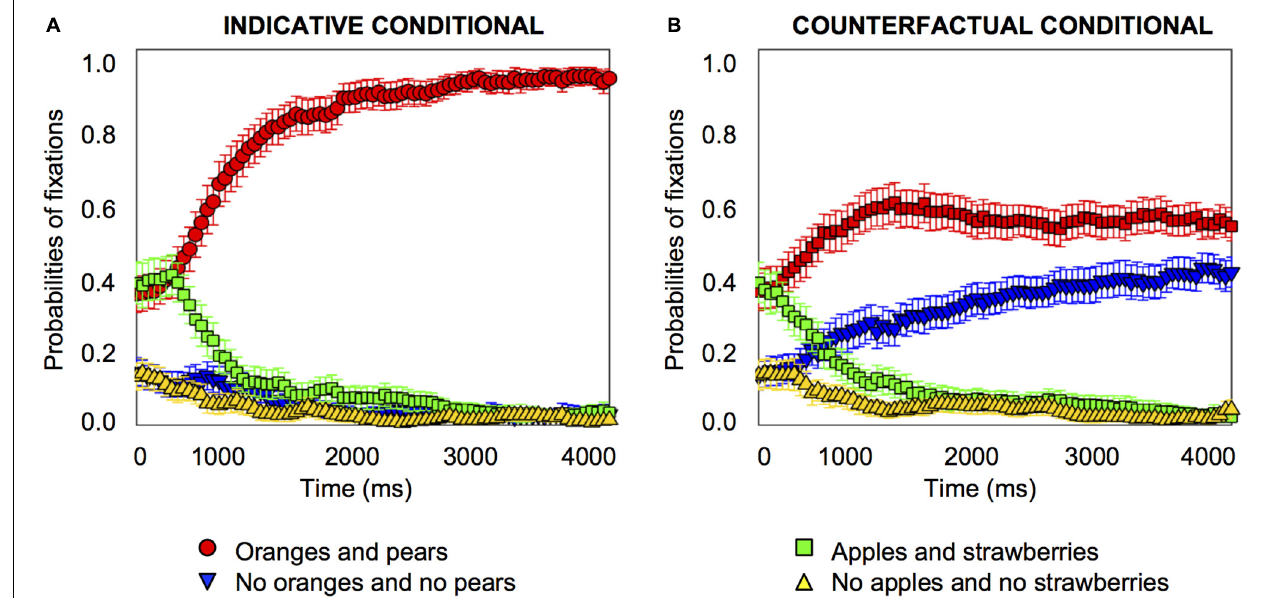
FIGURE 3 | Item-analysis probabilities of fixations for indicative conditionals, e.g., “if there are oranges, then there are pears” (A) and counterfactual conditionals, e.g., “if there had been oranges, then there would have been pears” (B) in Experiment 1. Error bars are 95% confidence intervals within items.